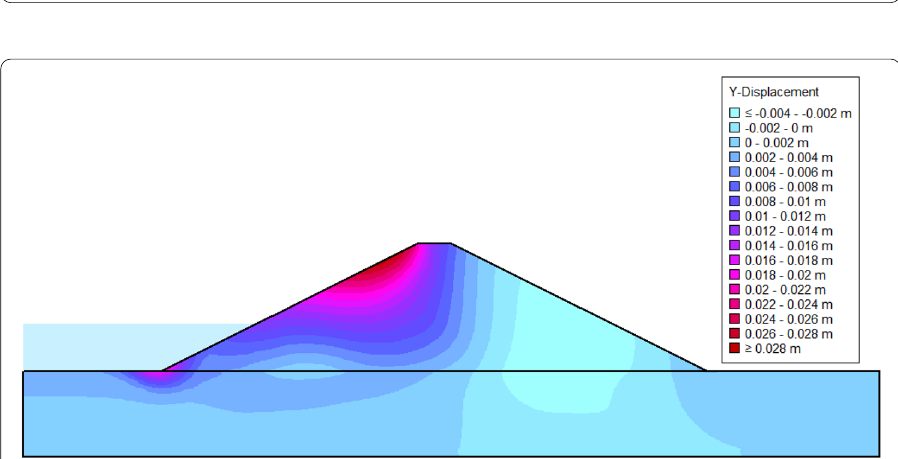
Fig. 28 Vertical displacement contours within the earthen dam upon partial drawdown of the reservoir on the 68th